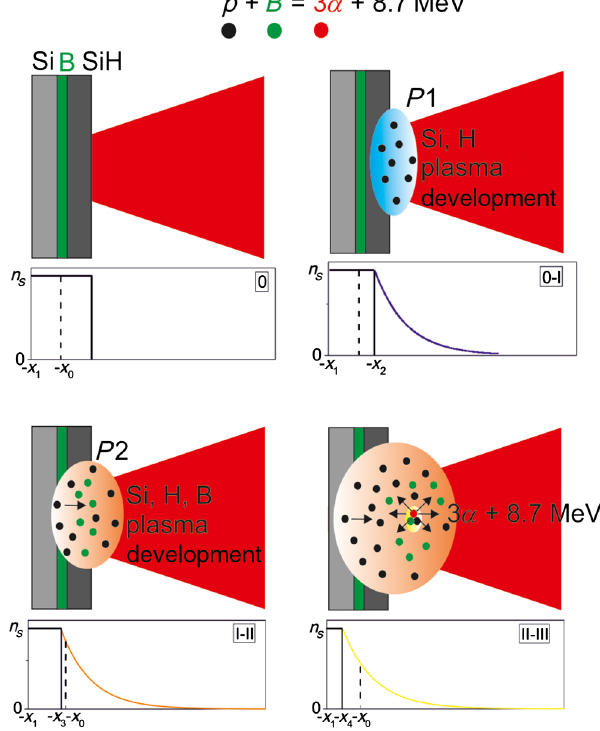
FIG. 5. Laser-target, laser-plasma, and proton-boron inter- actions in the 2-ns range before the maximum laser intensity [0-III in Fig. 1(b)]: n s is the solid density, 0 is the target surface position, x 0 is the depth of the boron atoms, x 1 is the substrate extension, x 2 , x 3 , and x 4 are the ablation depths at three given times, and P 1 and P 2 are plasmas generated by the laser pulse in the 0-I and I-II regions,